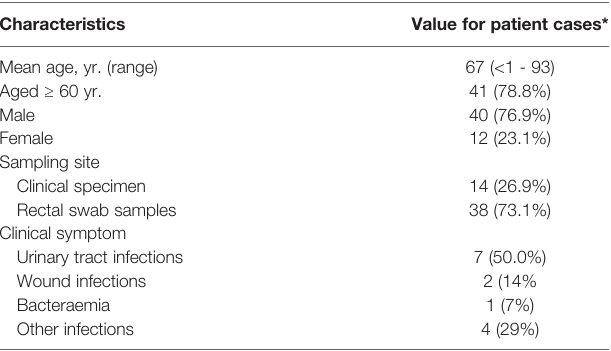
TABLE 1 | Demographics of patients carrying carbapenemase-producing Citrobacter spp. Isolates.